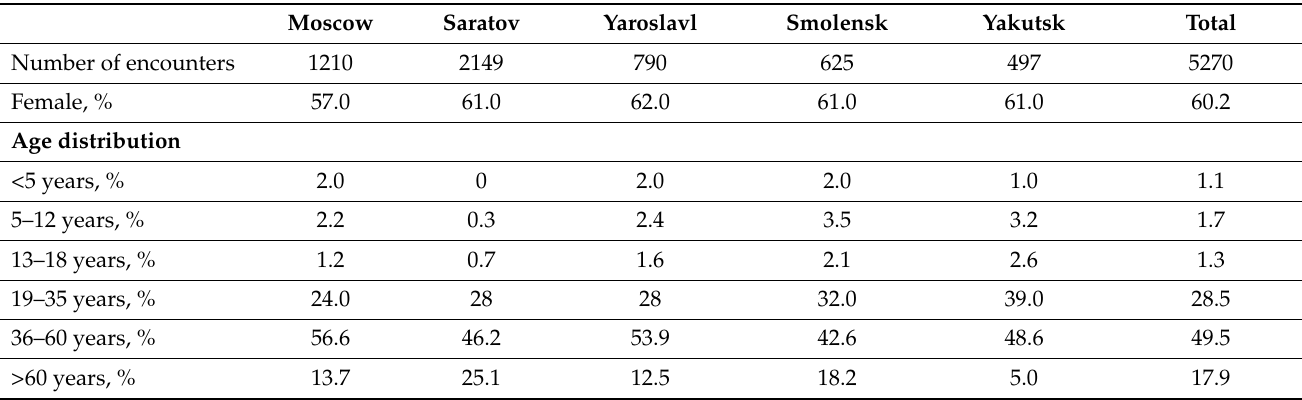
Table 2. Gender and age distribution of AM encounters in community pharmacies.